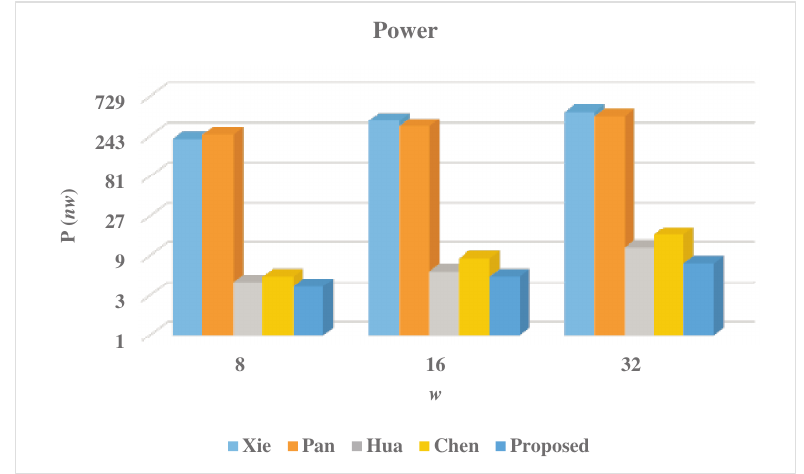
Figure 11. Comparison of consumed power results.